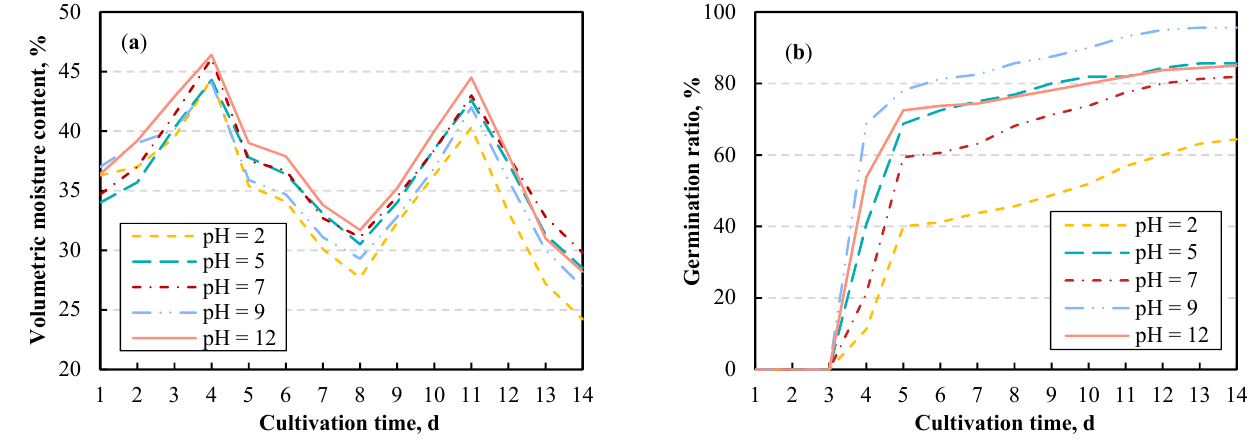
Figure 10. ( a ) Relationship between volumetric moisture content and cultivation time (0.25% XG content); ( b ) relationship between germination ratio and cultivation time (0.25% XG content).